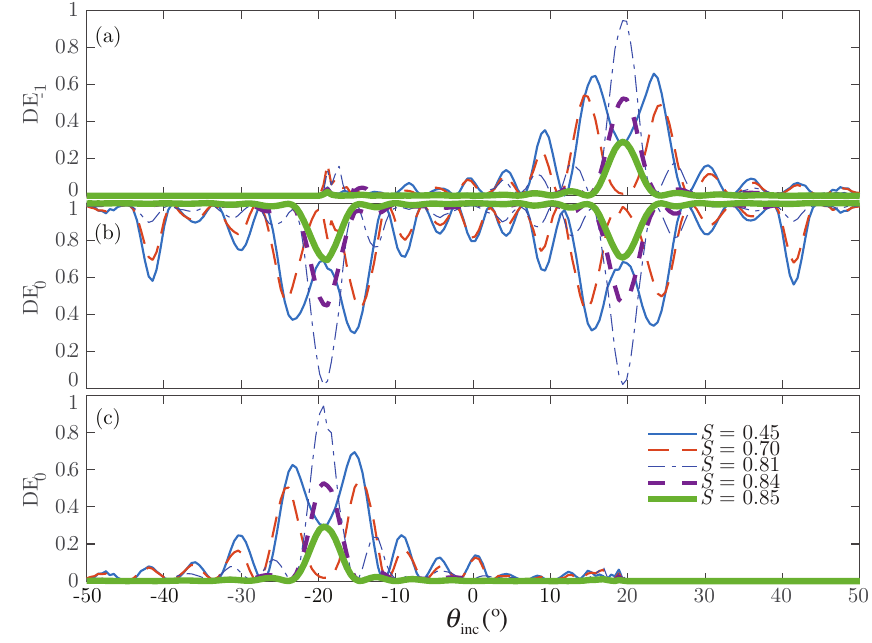
Figure 6. Diffraction efficiency as a function of the angle of incidence for different S parameter for Grating #2: ( a ) − 1st-order; ( b ) 0th-order; ( c )